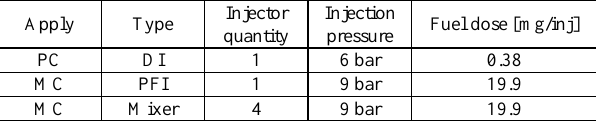
Table 3. Gas injection systems specification